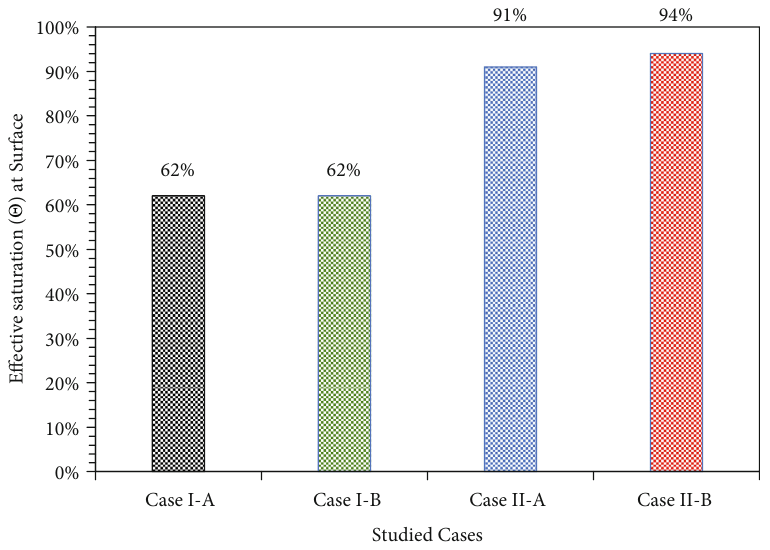
Figure 14: Normalized water content ( θ ) at the surface (150min drying